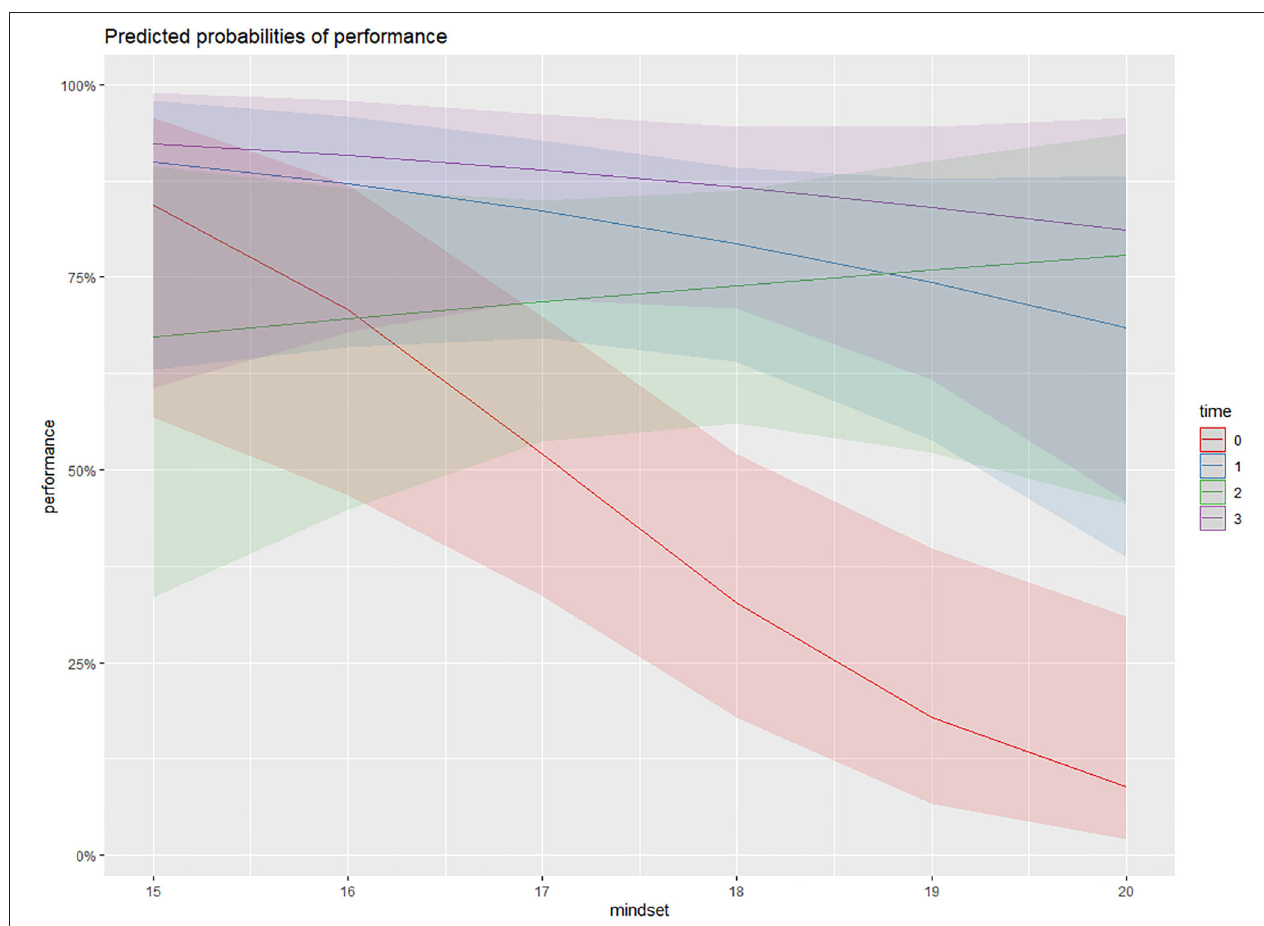
FIGURE 1 | The interaction effect of Time * Mindset in Model 3. The x -axis represents participants’ endorsement of growth mindset (range: 15–20). The y -axis represents the predicted response variable: Test Performance measured by the binary scores (range: 0–100%). The red, blue, green, and purple lines represent the trends of participants’ predicted score when growth mindset increases (from 15 to 20) given a specific Test Time Point (time 0 = Pretest, time 1 = Immediate posttest, time 2 = 2-month posttest, and time 3 = 5-month posttest). The figure shows that although the three posttest scores are significantly higher than the pretest scores, there are no significant differences between the posttest scores. Only the interaction effect between time 2 * growth mindset is significantly positive (Est = 0.97, p <